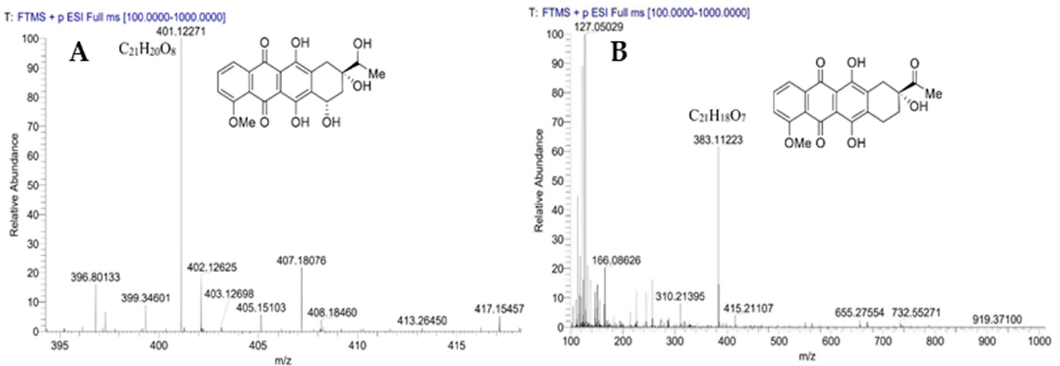
Figure 6. LC ‐ MS analysis of DnmSQ ‐ catalyzed reactions. ( A ) LC ‐ MS compound 8 and ( B ) LC ‐ MS compound 9.